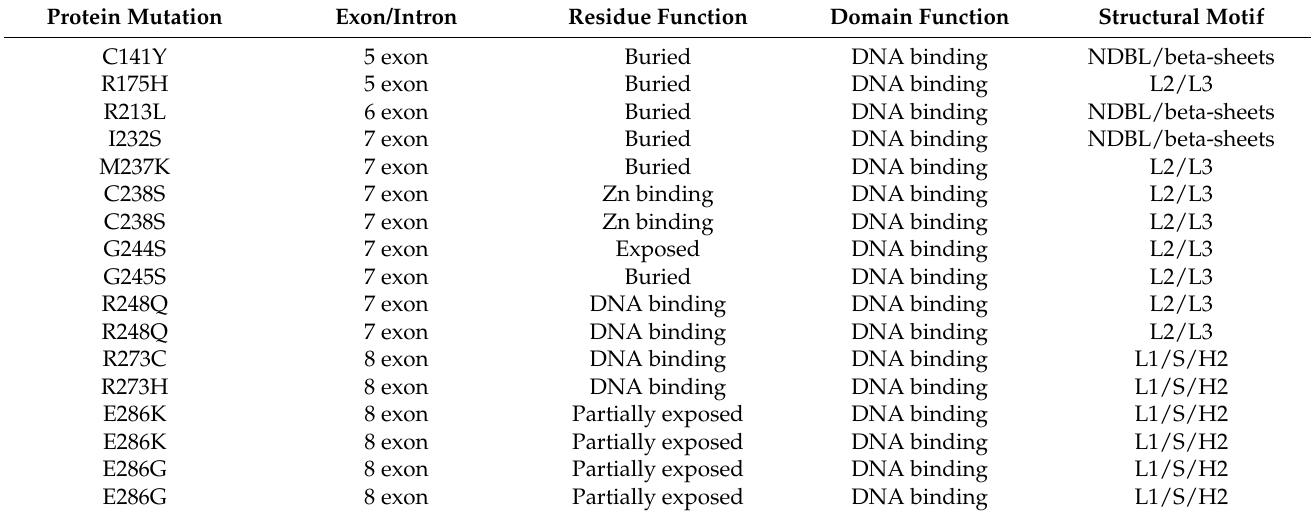
Table 4. Catalog of common and unique TP53 mutations for colon